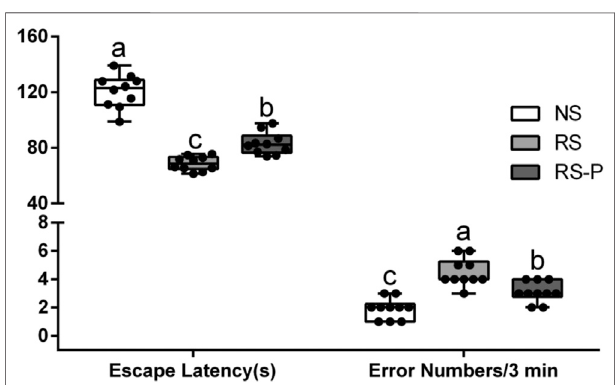
FIGURE 3 | Effects of L. johnsonii BS15 on the escape latency and error numbers by passive avoidance test. Data are presented with the means ± standard deviation ( n (cid:2) 10). Bars with different letters are signi fi cantly different on the basis of Duncan ’ s multiple range test ( P < 0.05).